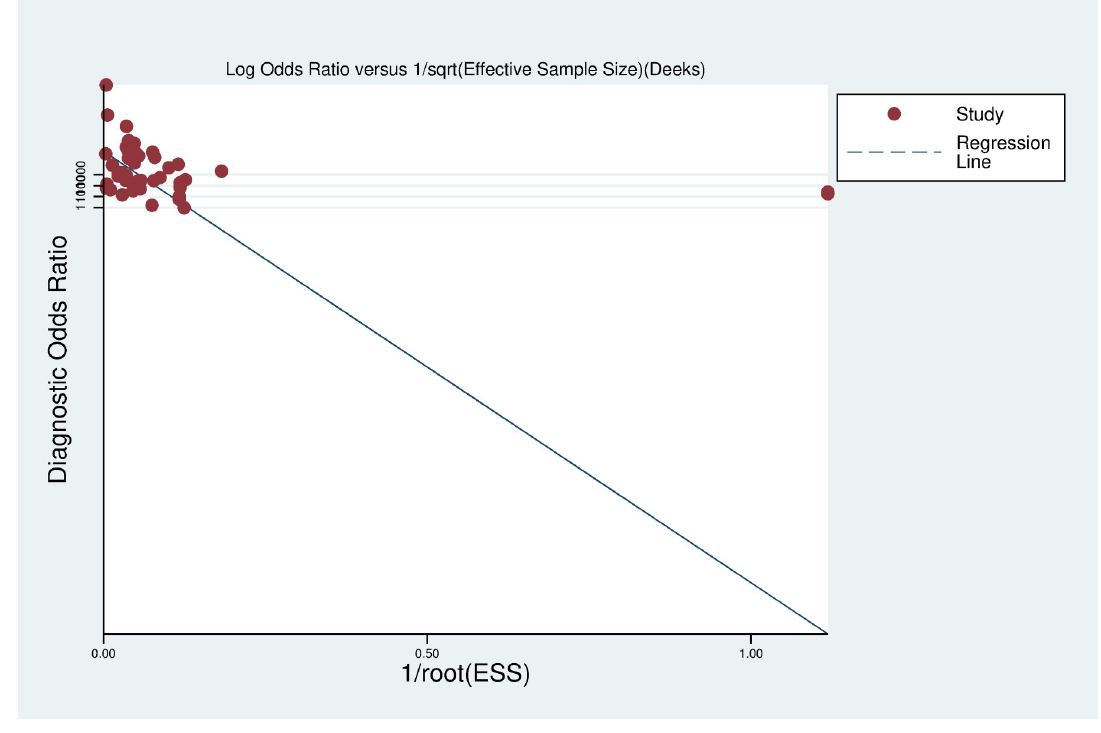
Fig 3. Deek’s funnel